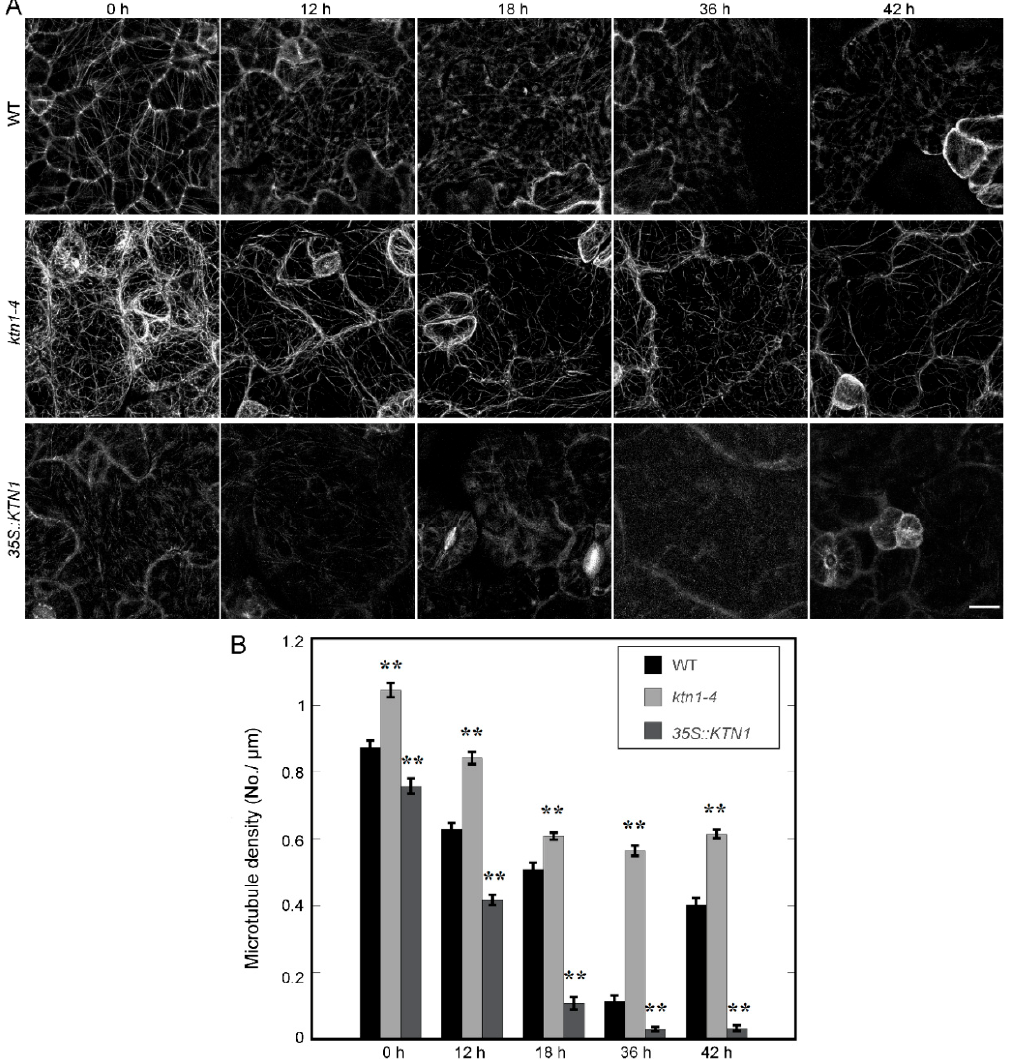
Figure 3. AtKTN1 modulates cortical microtubule disruption and reassembly in cotyledon pavement cells during the early stage of salt stress (0 h–42 h). ( A ) Sequential images of cortical microtubule alterations induced by 200 mM NaCl in four-day-old WT (Col-0), ktn1-4 and 35S::KTN1 seedlings expressing GFP-TUA6 for the indicated time. Bar = 10 µ m. ( B ) Quantification of cortical microtubule density in cotyledon pavement cells of WT (Col-0), ktn1-4 and 35S::KTN1 . The data shown in ( A ) were quantified by MBF imageJ software. N ≥ 22 cells. Error bars indicate SE. ** P < 0.01 by a Student’s t test.